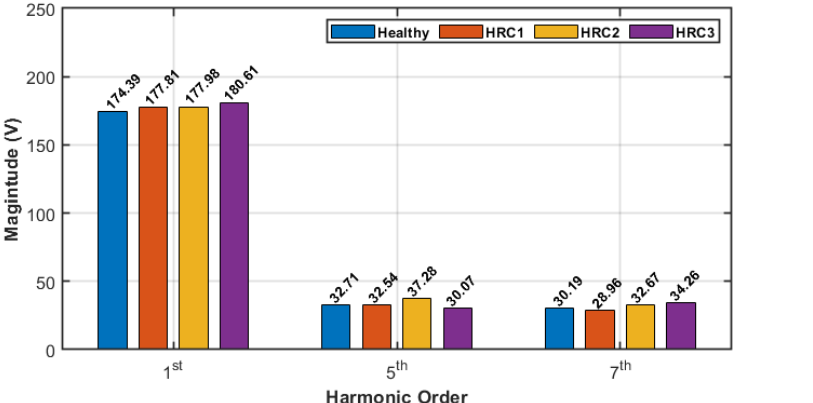
Figure 16. Variations in the harmonic content of stator voltage spectrum for healthy and faulty machine under HRC fault in DTC